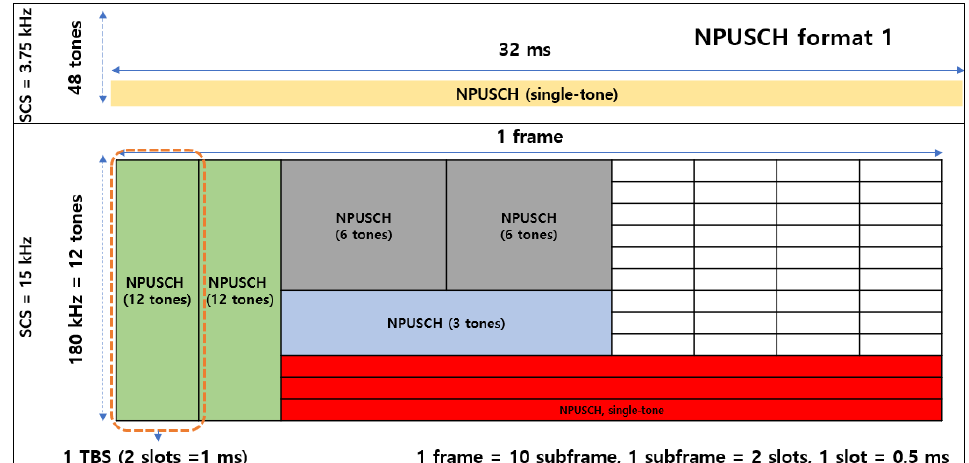
Figure 3. NB-IoT uplink frame structure (NPUSCH format 1).